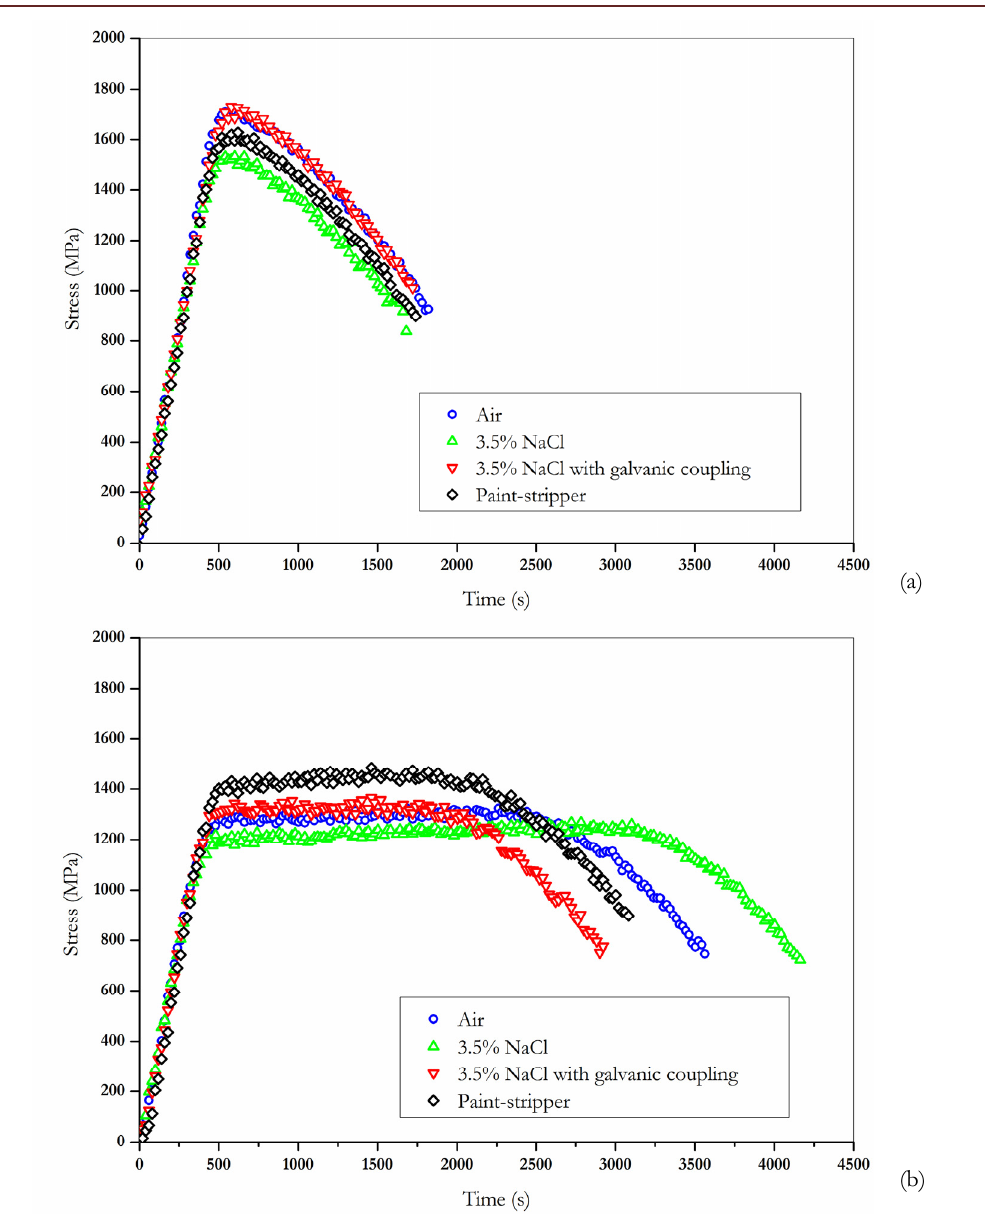
Figure 3: Stress-Time to Failure curves for Maraging peak-aged at 480°C (a) and at 535°C (b).